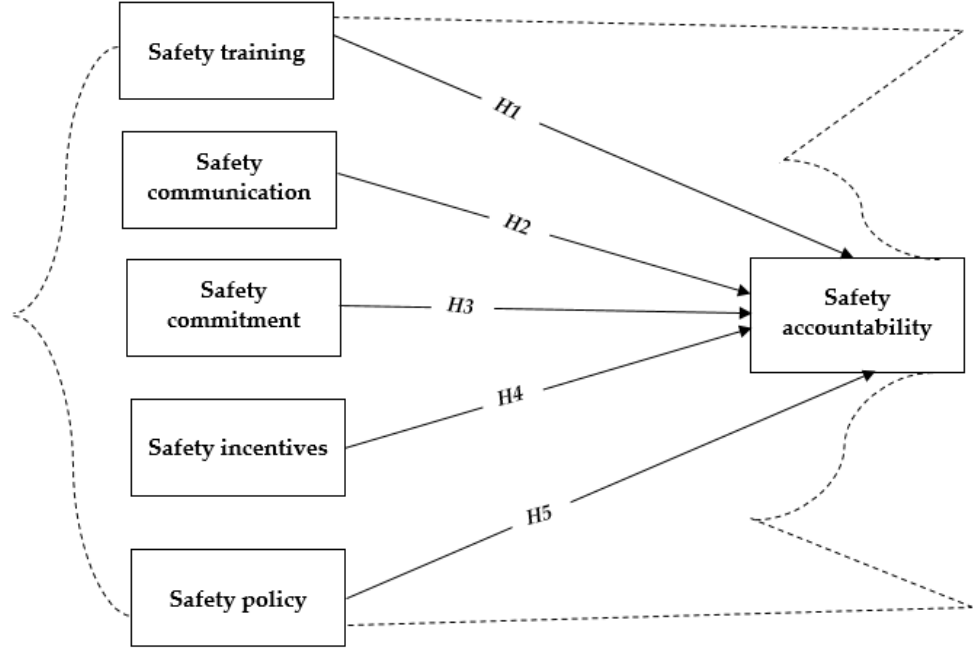
Figure 1. Conceptual Model. Source: Developed by the